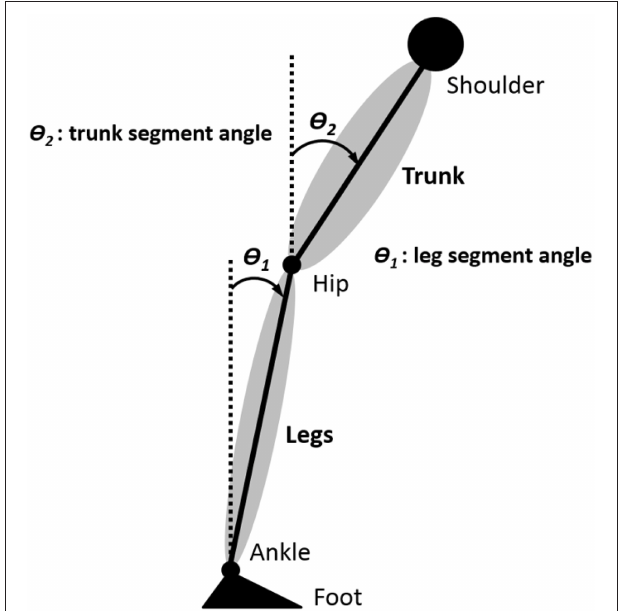
FIGURE 3 | Definition of body segment angles. The leg angle θ 1 ( t ) and trunk angle θ 2 ( t ) with respect to vertical were determined by the anterior-posterior (AP) and vertical displacement of the shoulder, hip, ankle marker, and foot